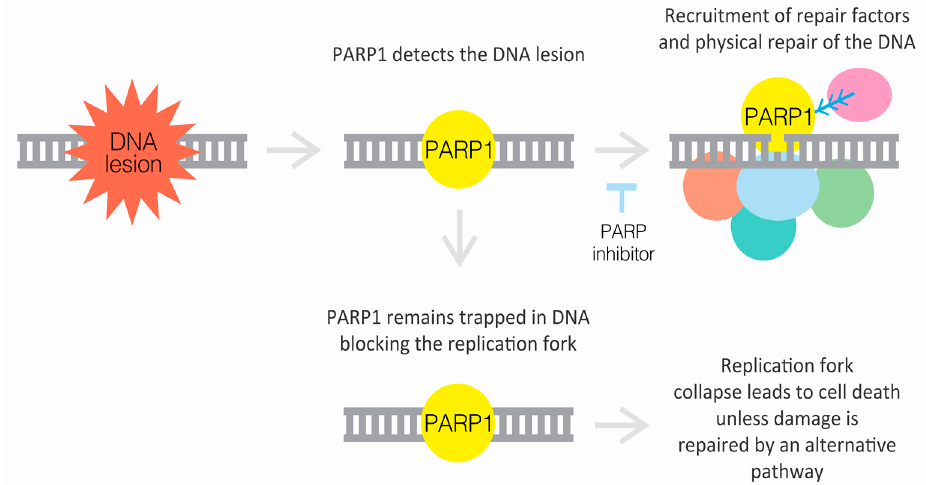
Figure 2. PARP inhibitors (PARPi) reduce the catalytic activity of PARPs. In addition, PARPi trap PARP at the site of DNA damage by preventing PARP from detaching from DNA. Cytotoxic PARP-DNA complexes prevent replication fork from progressing and lead to cell death unless damage is repaired [32,36].